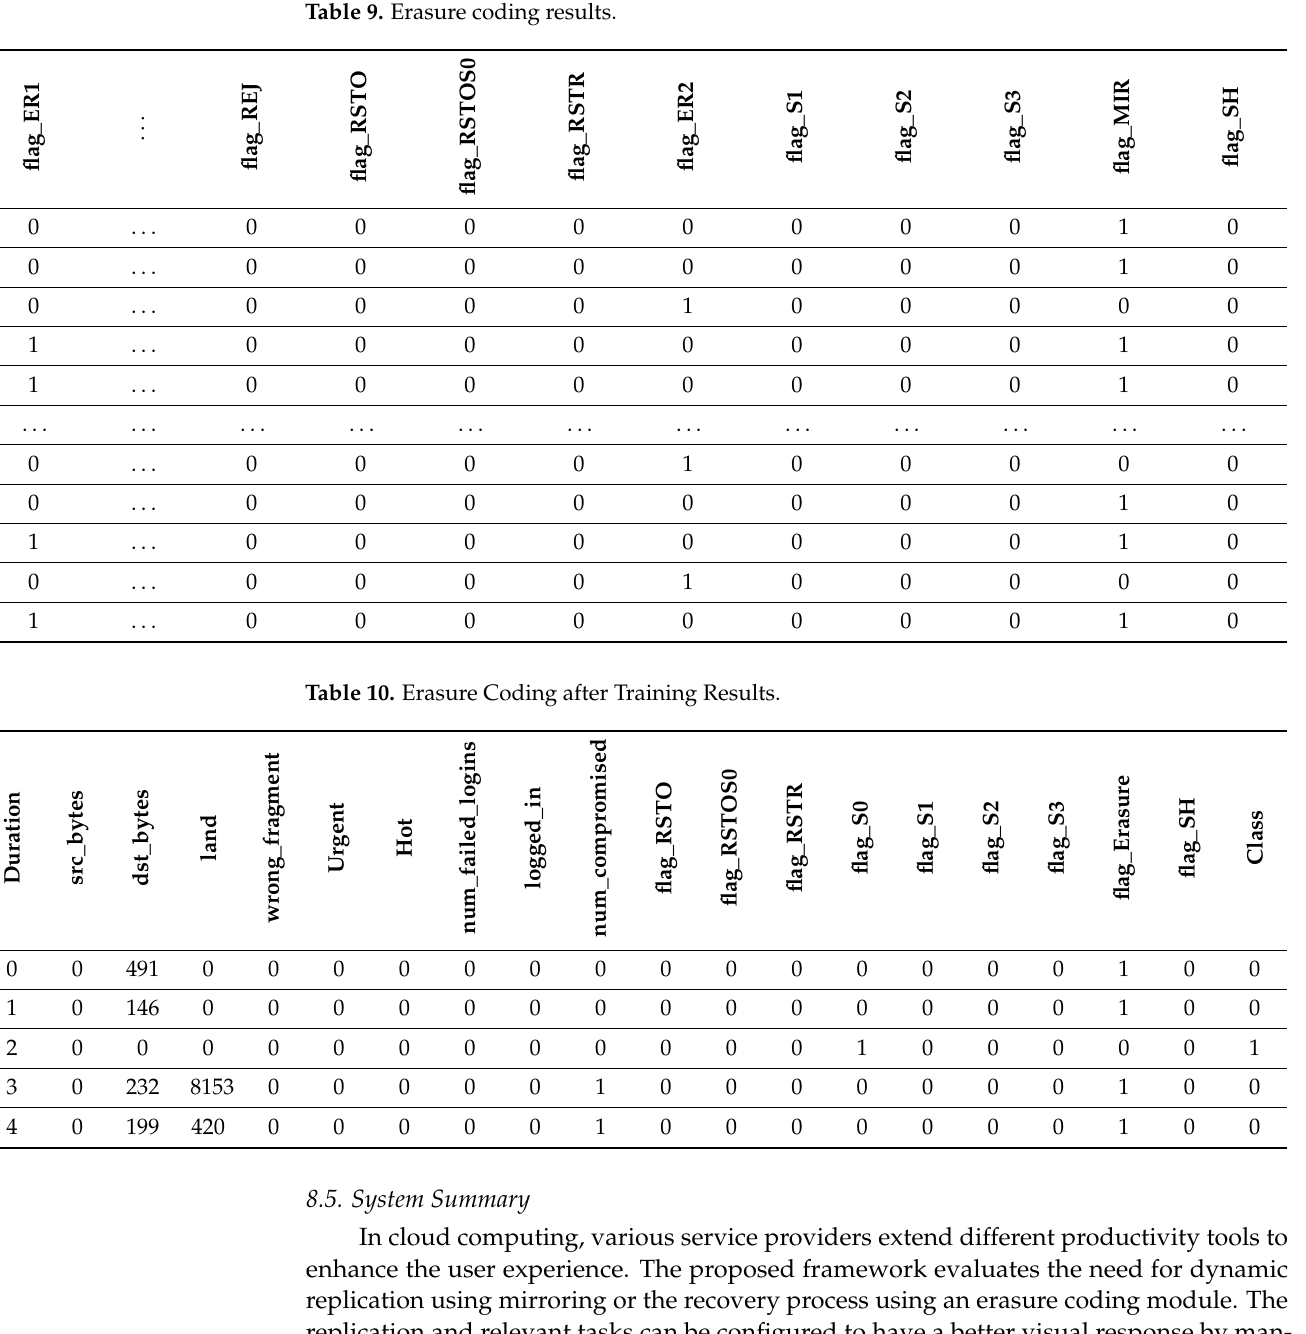
Table 9. Erasure coding results.